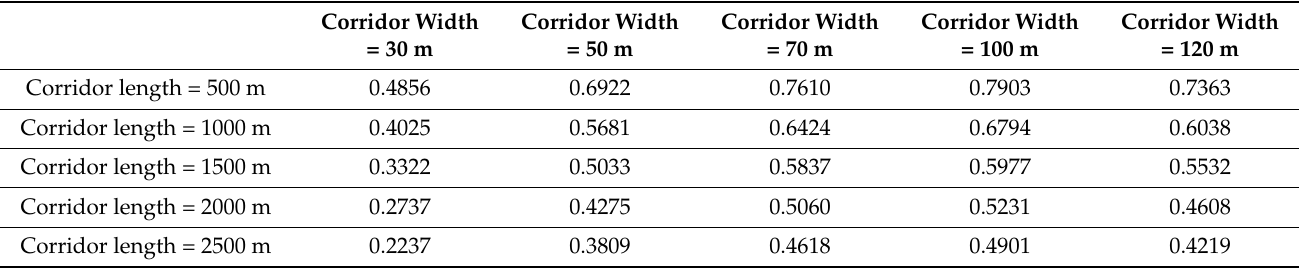
Corridor Width Corridor Width Corridor Width Corridor Width = 30 m = 50 m = 70 m = 100